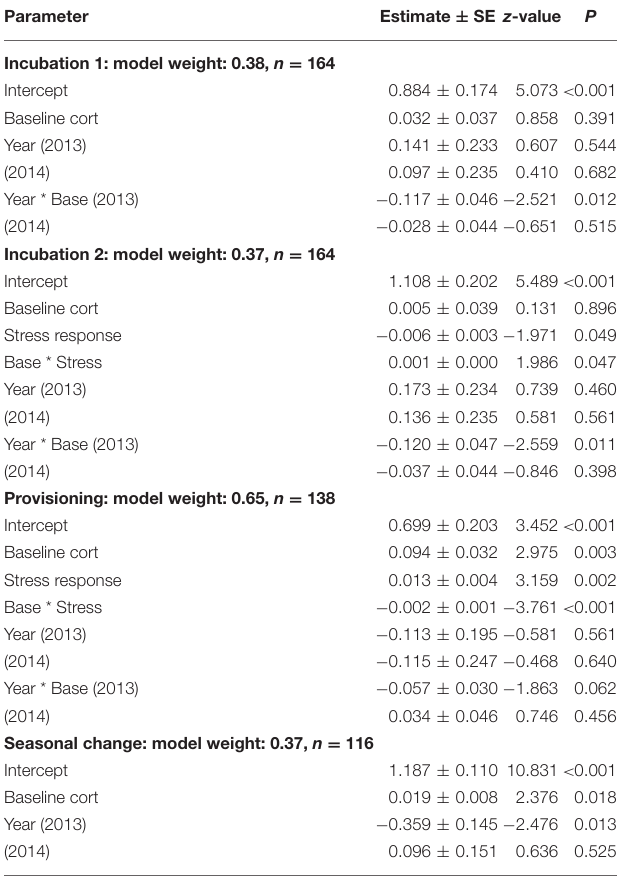
TABLE 2 | Best-fit models of reproductive success (number of nestlings fledged) in female tree swallows. Parameter Estimate ± SE z -value